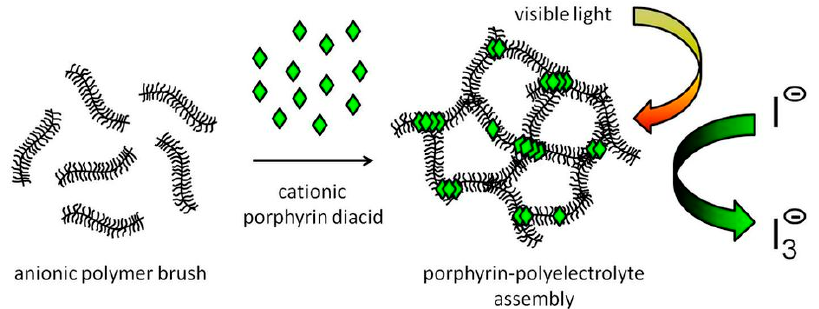
Scheme 2. Formation of a supramolecular polyelectrolyte-porphyrin photocatalyst by